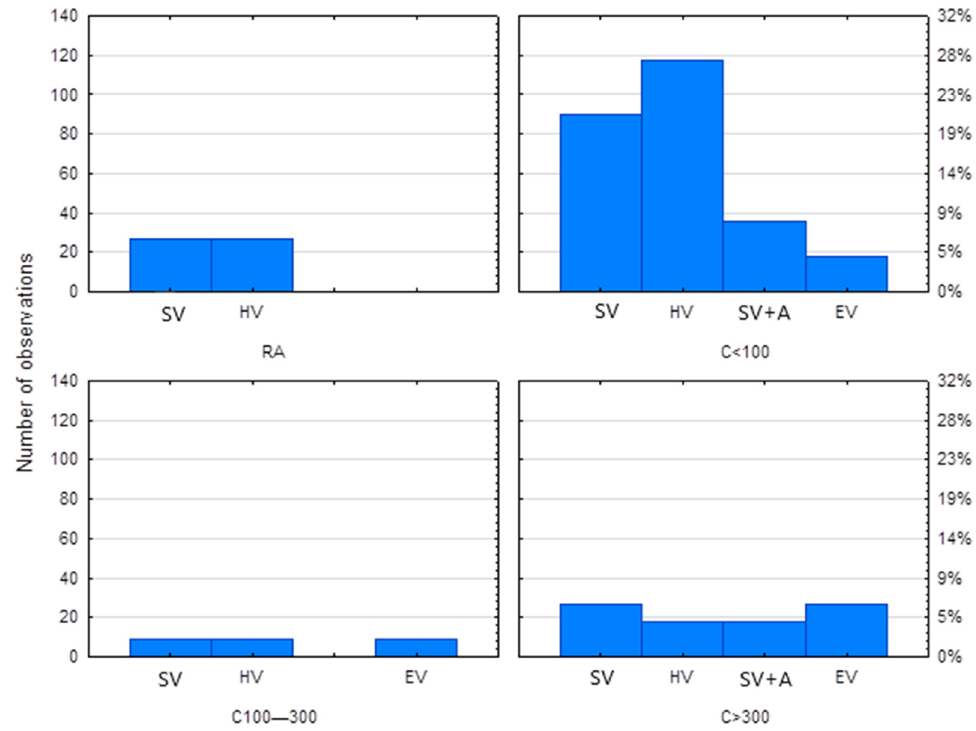
Figure 5. Popularity of car types by source of propulsion—analysis by the grouping variable “place of residence”. Abbreviations: RA—inhabitants of rural areas; C < 100—inhabitants of small cities (up to 100,000 inhabitants); C100–300—inhabitants of medium-sized cities (from 100,000 to 300,000 inhabitants); C > 300—inhabitants of the largest cities—over 300,000 inhabitants.